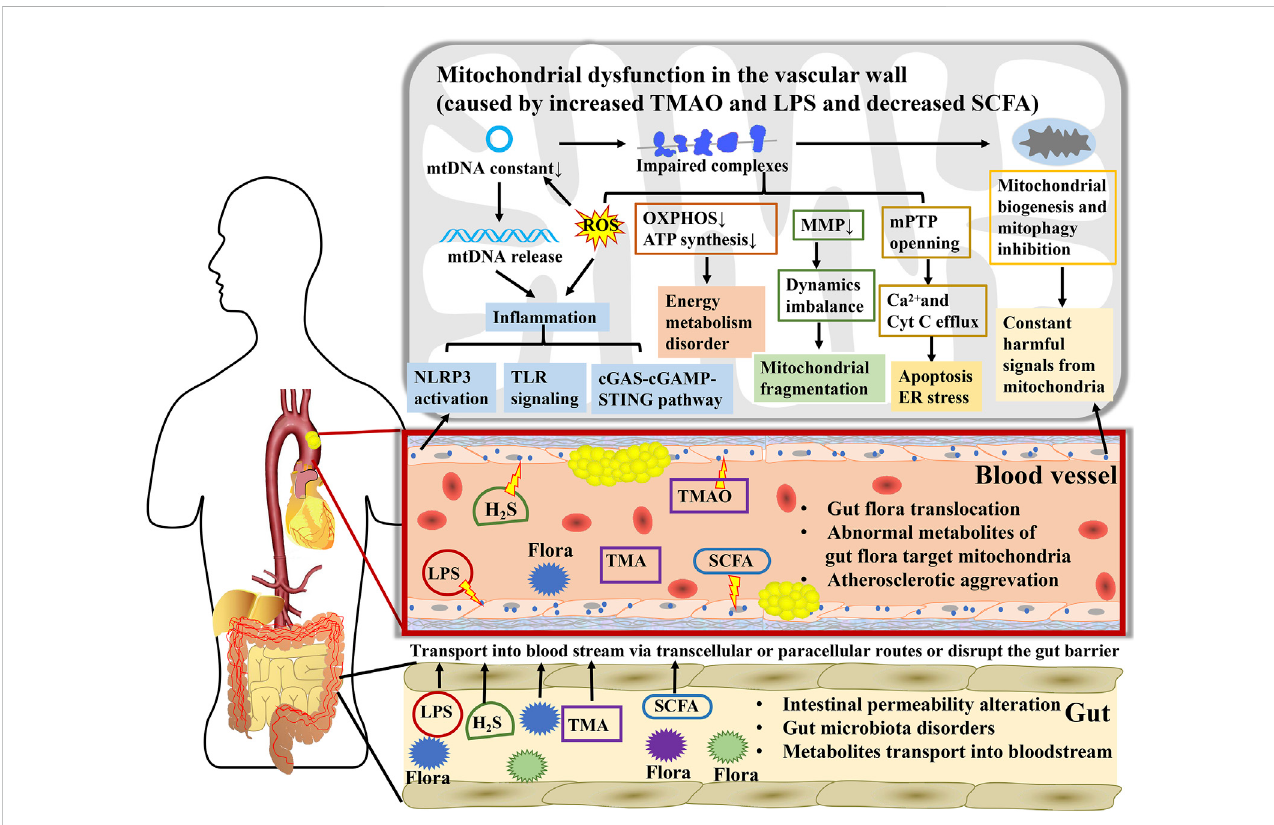
FIGURE 2 Akeymediatorlinkinggutmicrobiotatoatherosclerosis,mitochondriaparticipateintheinteractionbetweennumerousmetabolitesfromgutmicrobiota and atherosclerosis. During atherosclerosis, gut microbiota disorders and intestinal permeability alteration contribute to direct transposition of fl ora to arteries.Microbialmetabolitesaretransportedintothebloodstream via transcellularorparacellularroutesordisruptingthegutbarrierandsubsequentlyaffect mitochondrial function in blood vessels cells. Mitochondria expand the in fl uence of TMAO, LPS, H 2 S, and SCFA on energy metabolism, oxidative stress, in fl ammatory cascade reaction, and endothelial cell injury through regulating mtDNA release, ATP synthesis, MMP, mPTP, mitochondrial biogenesis, and mitophagy, further promoting or opposing the atherogenic